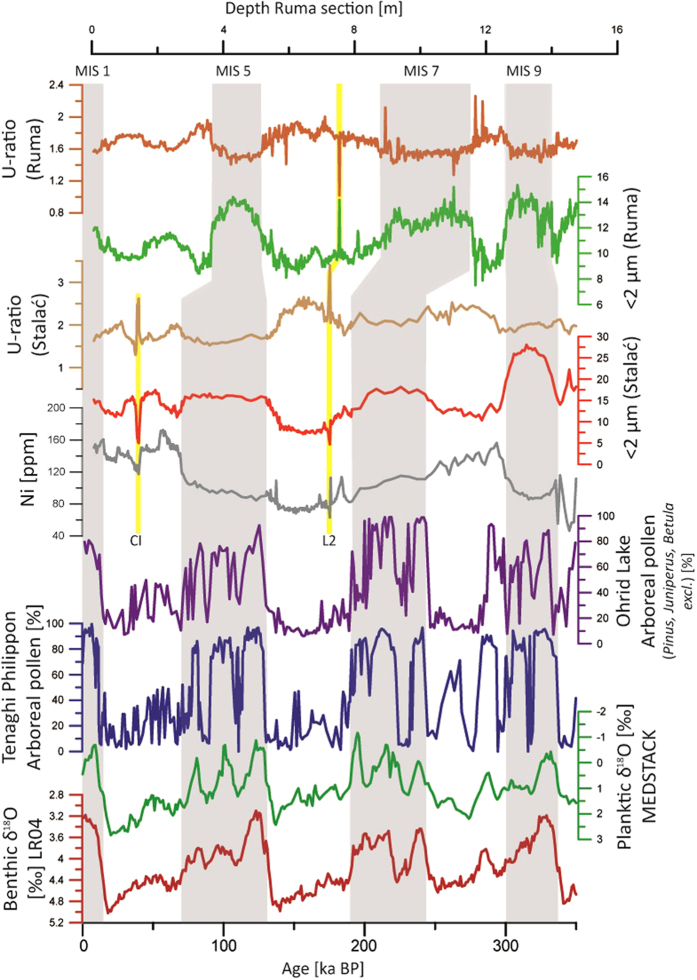
Direct comparison between the benthic δ18>O LR04 stack59, MEDSTACK planktic δ18O data39, arboreal pollen from Tenaghi Philippon31, arboreal pollen (Pinus, JuniperusandBetula are excluded) from the Lake Ohrid core34, U-ratio and <2 μm fractions from the Stalać section (plotted versus age, abscissa), U-ratio and <2 μm fractions from the Ruma section 26 (the only section with existing grain-size record spanning the last three glacial-interglacial cycle in Middle Danube Basin; plotted vs. depth).Note the differences between scales on the plots presenting Stalać and Ruma grain-size data. Tephra layers are marked with yellow lines; “CI” refers to the Campanian Ignimbrite/Y-5 tephra layer and “L2” refers to the L2 tephra layer.